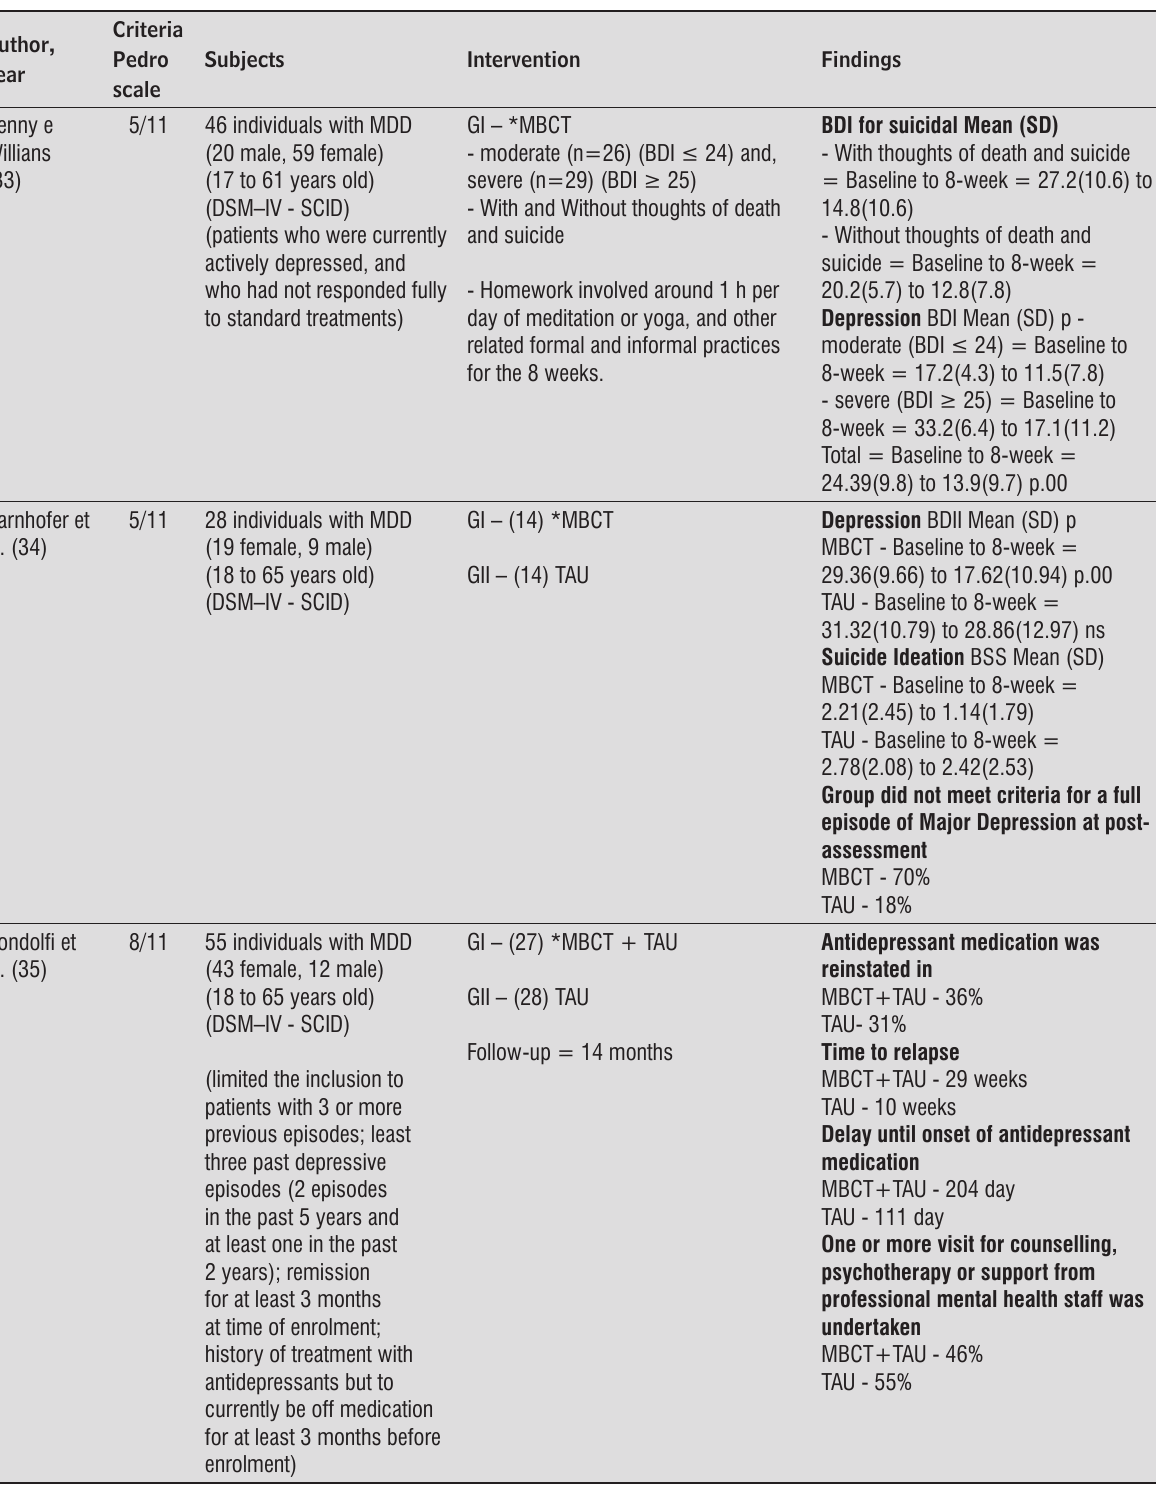
Table 2 - Characteristics of the studies Interventions